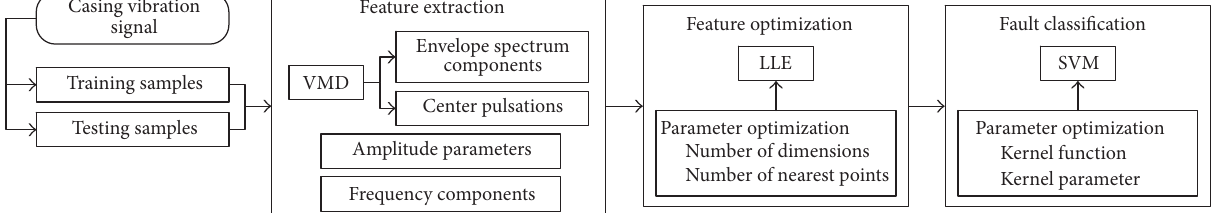
Figure 12: Procedure of casing vibration fault diagnosis in this paper.